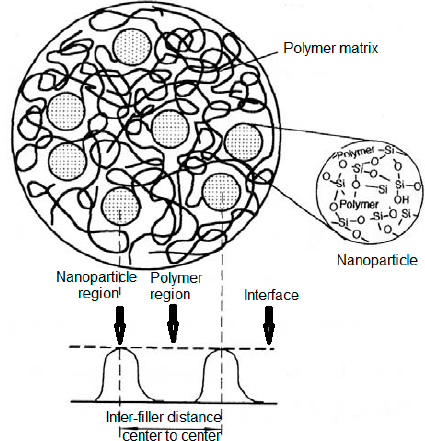
Figure 8. Wilkes’ model of the interface formed between silica nanoparticles and polymer matrix (© 2016 IEEE. Reprinted, with permission, from [76]). (© 2016 IEEE. Reprinted, with permission, from